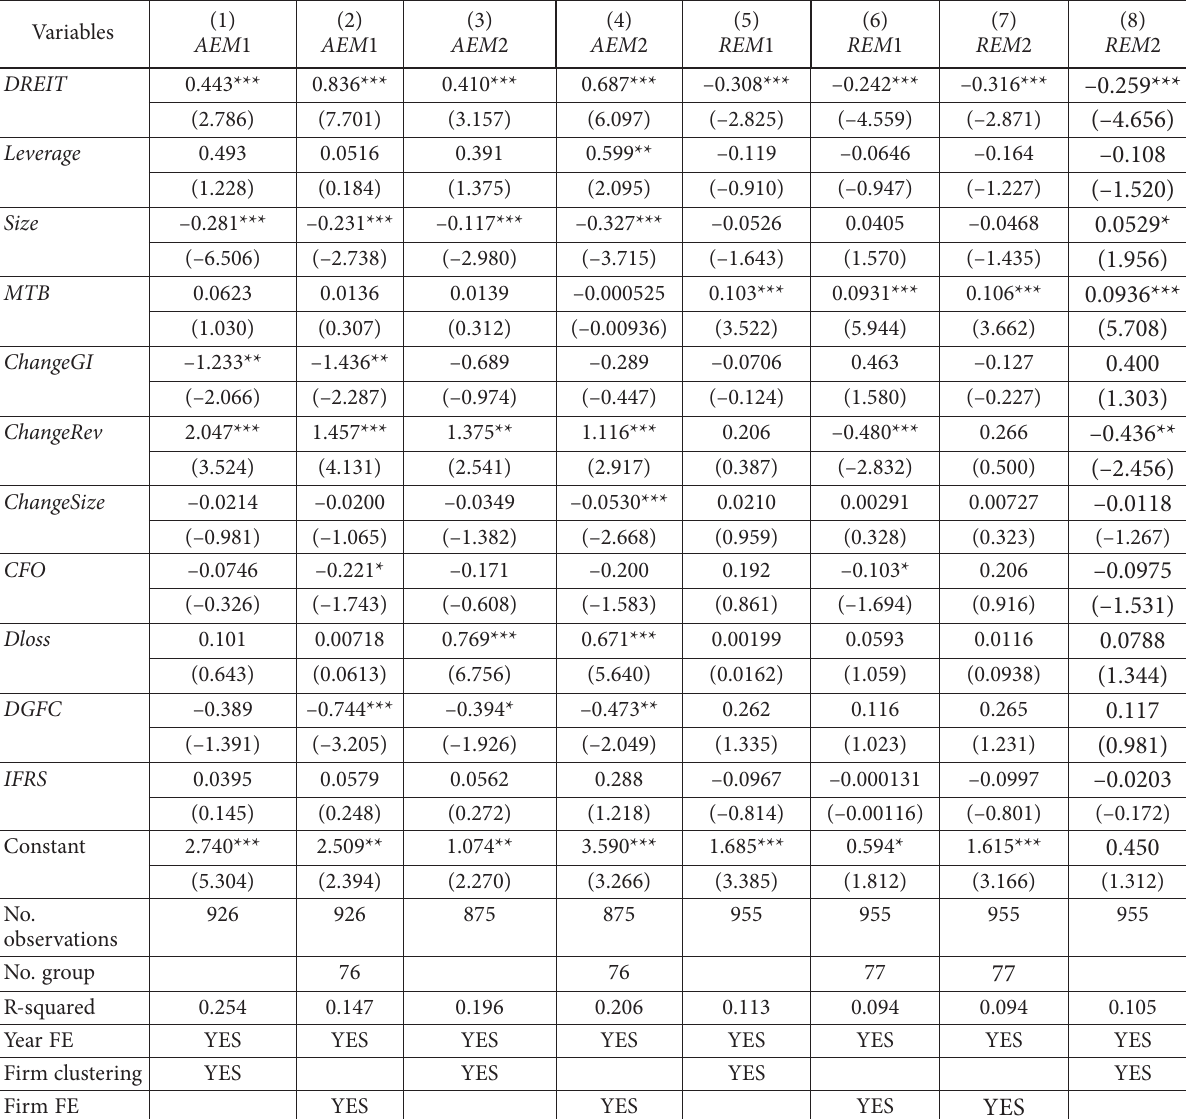
Table 5. Differences in EM between REITs and non-REIT